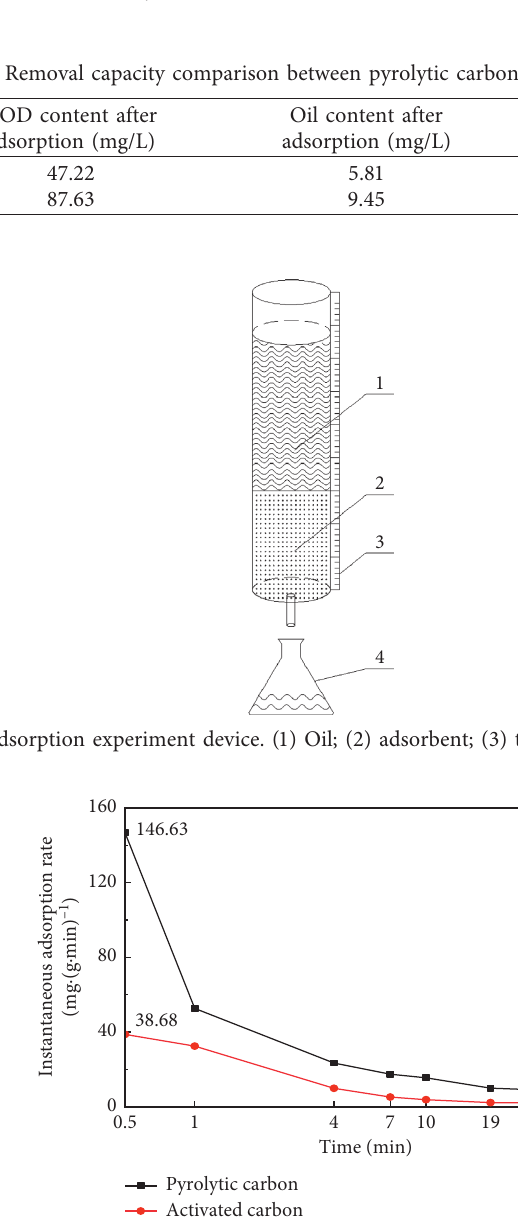
Figure 5: Comparison of instantaneous adsorption rate of pyrolytic carbon and activated carbon on diesel.